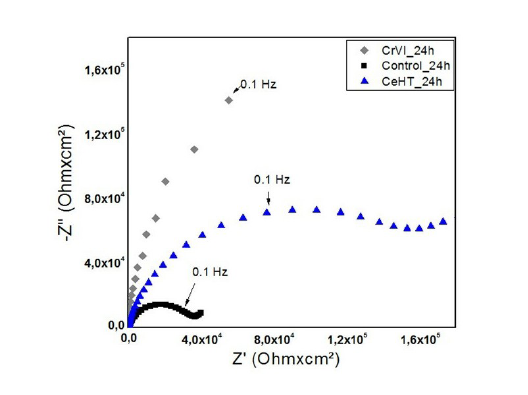
Figure 2. Comparative Nyquist plots for AA1230 clad on AA2024 alloy with various pre-treatments after 24 h of exposure to 0.1 mol L -1 NaCl solution.